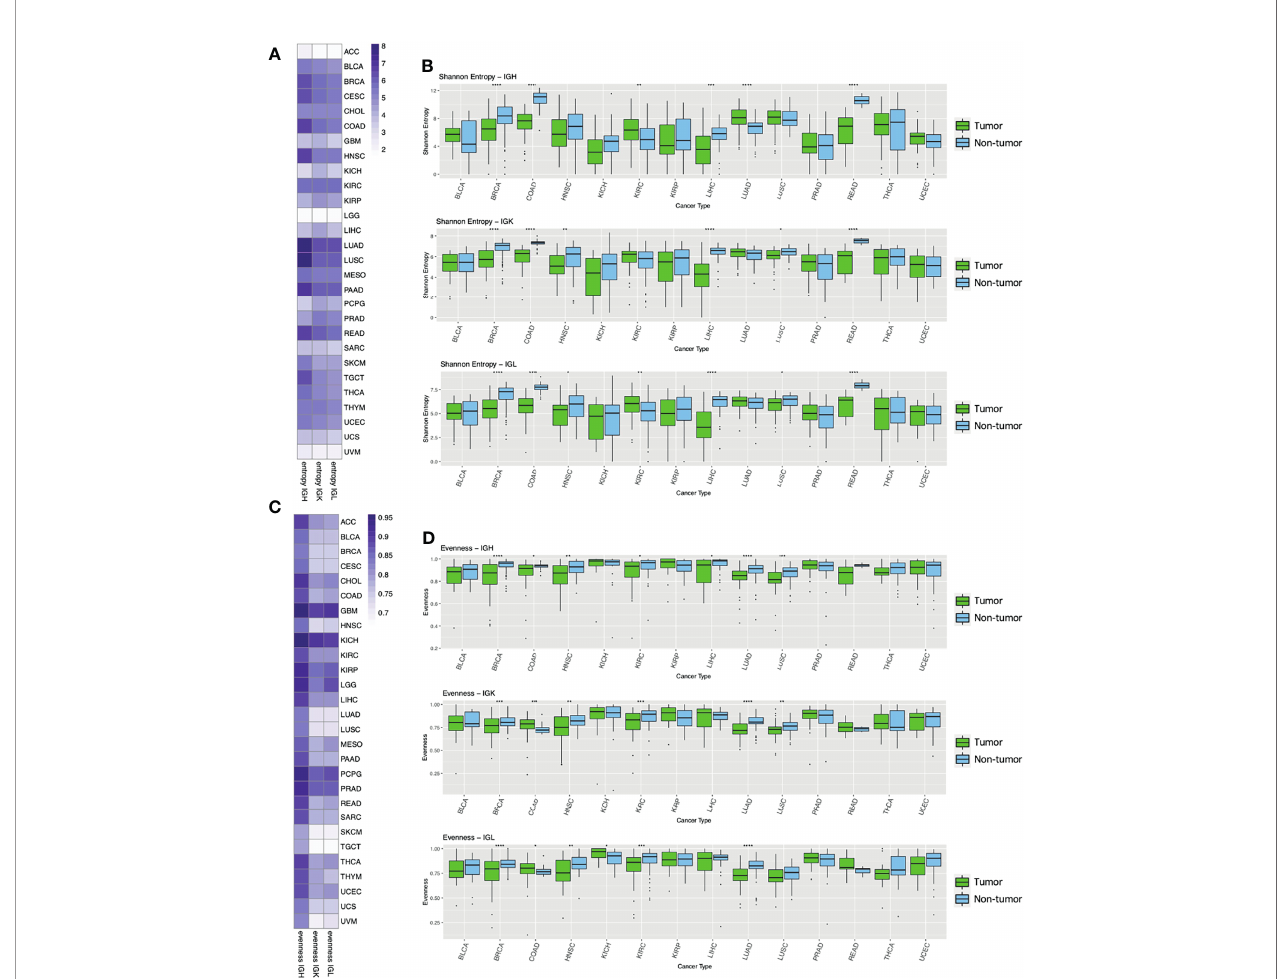
FIGURE 2 | Entropy and evenness analysis across tumor types and between tumor and adjacent non-tumor samples. (A) The heatmap depicts the mean Shannon entropy value for each tumor type in each chain. (B) The boxplots show the Shannon entropy indexes for tumors (green) and adjacent non-tumor samples (blue) for the 14 tumor types with at least 10 adjacent non-tumor samples. Statistical signi fi cance was calculated using the Wilcoxon rank-sum test. Signi fi cant p-values are indicated by symbols above the box plots with one star corresponding to p-value<=0.05, two stars corresponding to p-value<=0.01, three stars corresponding to p-value<=0.001, and four stars corresponding to p-value<=0.0001. (C) The heatmap shows the mean Pielou ’ s evenness index for each tumor type in each chain. (D) The boxplots show the evenness index for tumors (green) and adjacent non-tumor samples (blue) and statistical signi fi cance was calculated as described